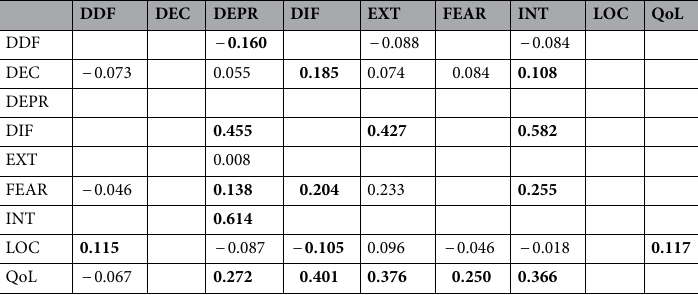
Table 5. Total effects. Significant values are in